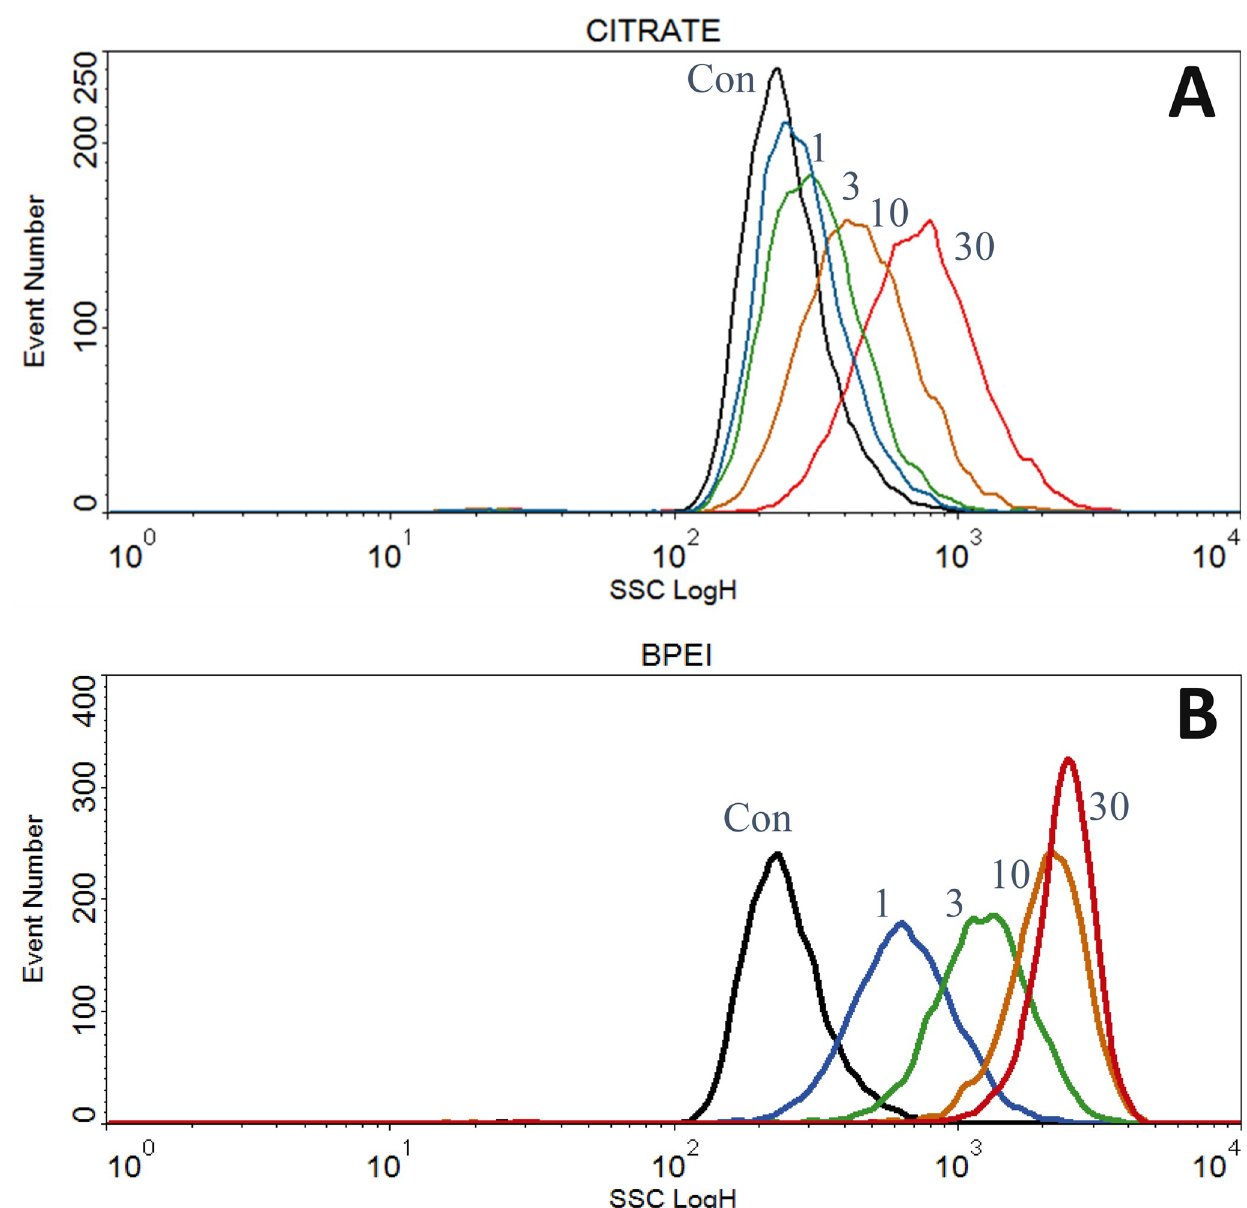
Fig 1. Flow cytometry side scatter ssc measurements of AgNP treated cells. Side scatter SSC measurement of cells were made after treatment with AgNP- CIT and AgNP-bPEI doses between 1 μ g/ml and 30 μ g/ml for 24 hours. AgNP-CIT (Fig 1A, top) and AgNP-bPEI (Fig 1B, bottom).